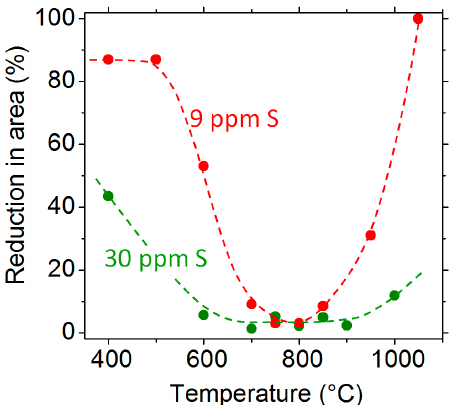
Figure 1: The reduction in area measured after tensile testing at different temperatures for the two sulphur contents.